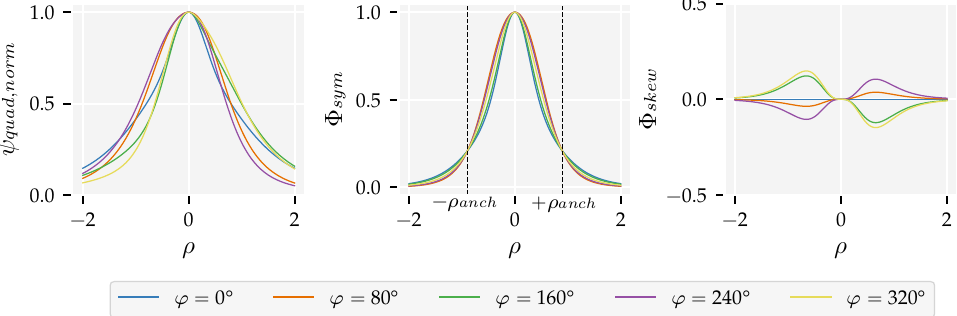
Figure A2. Quadrature profiles ψ quad , norm (left panel) of a continuous sensor array for five source directions ϕ (same as Figure A1). Furthermore, the two constituting functions Φ sym ( ρ , ϕ ) (middle panel) and Φ skew ( ρ , ϕ ) (right panel) are shown. These functions are, respectively, even and odd in ρ . At the secondary anchor points ± ρ anch the function Φ sym ( ρ , ϕ ) provides angle independent values which may be employed to determine the source distance d before the source direction of motion ϕ is